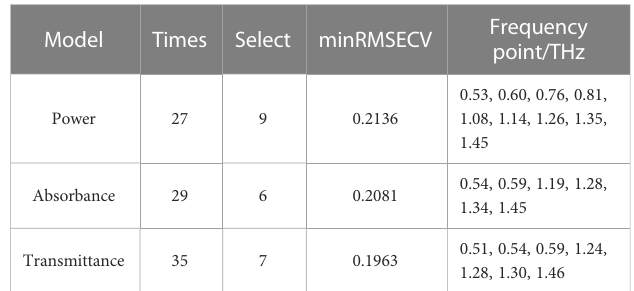
TABLE 3 esults of feature frequency band extraction.